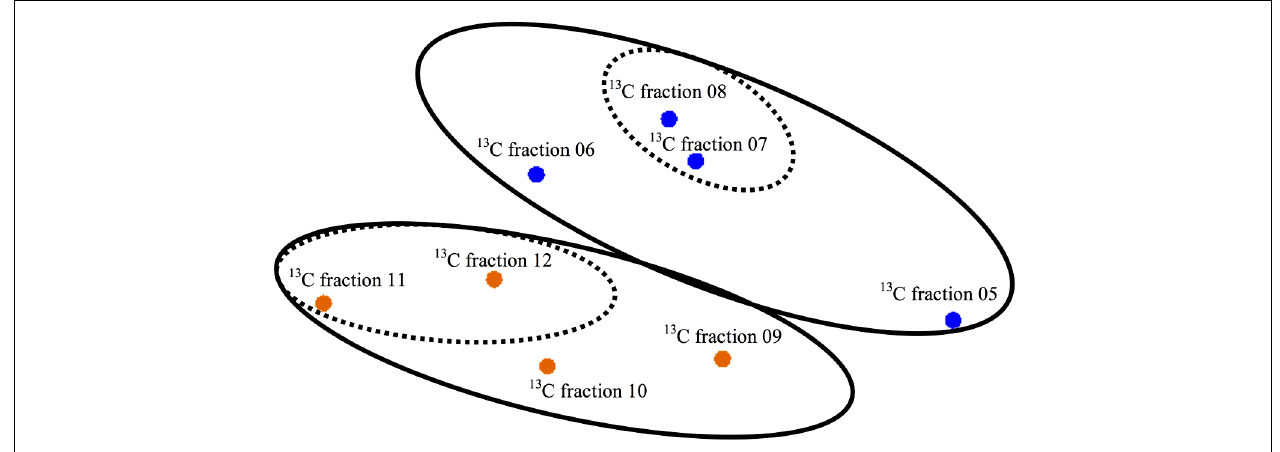
FIGURE 1 | Multidimensional scaling (MDS) plot ofT-RFLP data based on presence or absence ofTRFs. Orange symbols show light, non-enriched fractions and blue symbols show heavy, enriched fractions. Solid ellipses drawn on graph illustrate different groups at the p = 0.086 level